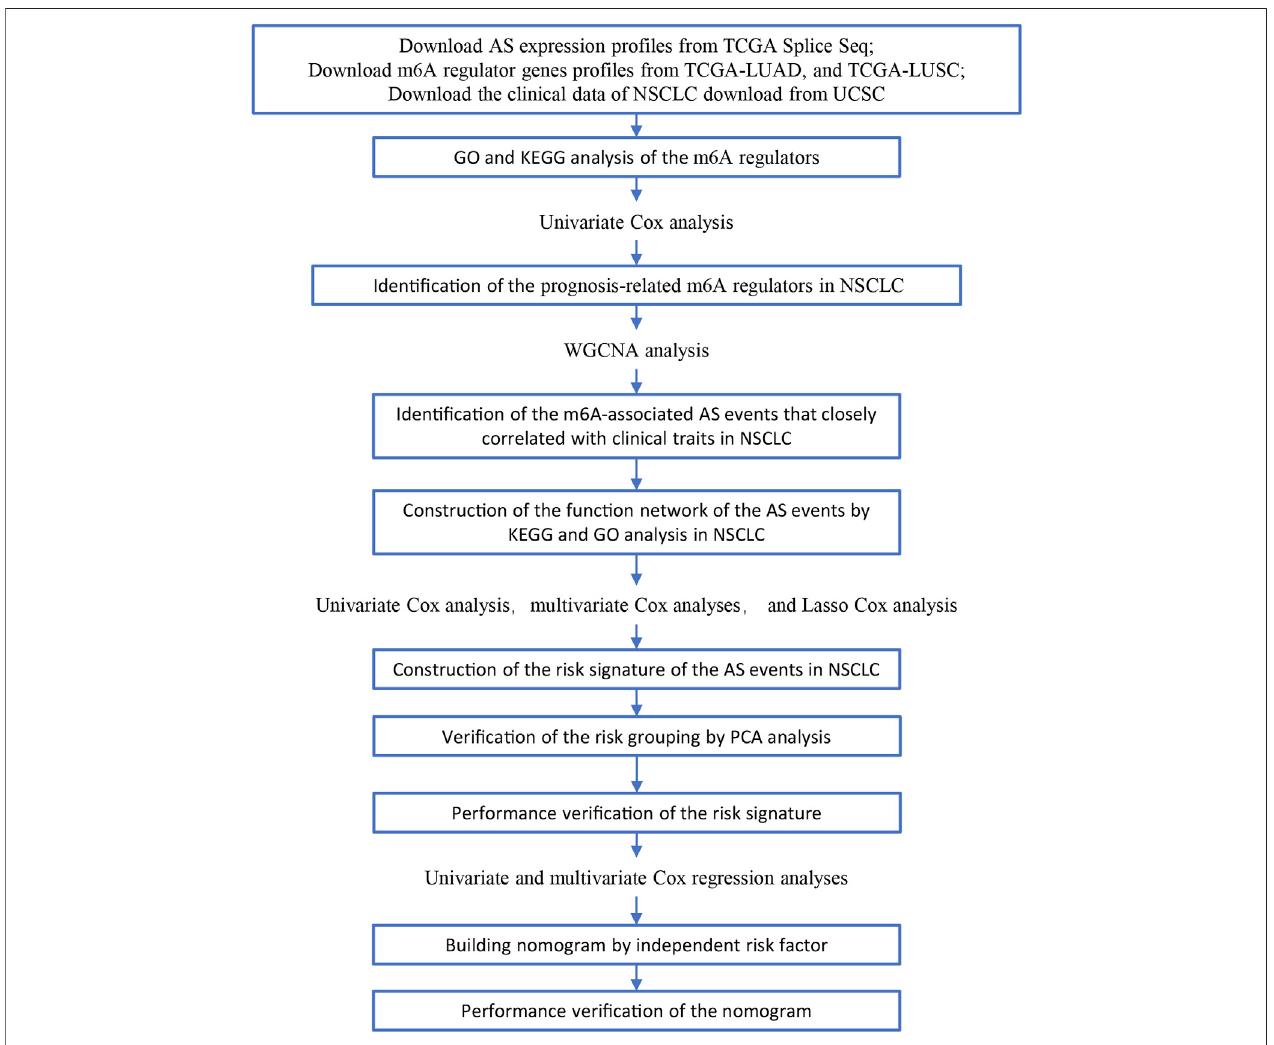
FIGURE 1 | Illustration of the work fl ow in this